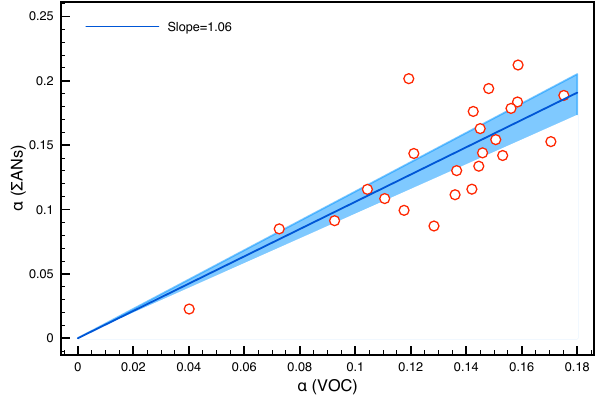
Figure 6. Correlation between daytime-averaged α estimated us- ing the VOC-ensemble method (Sect. 3.2.1) and the oxidation- production method (Sect. 3.2.2). The shaded area corresponds to the 95% confidence interval for the regression slope passing through the origin. The 1 : 1 line is within this